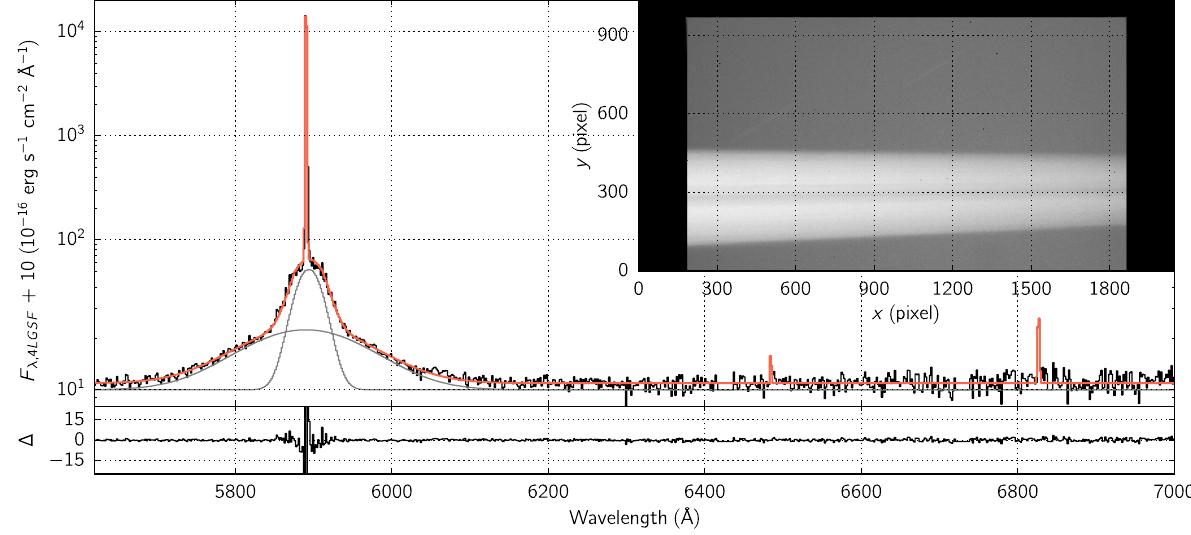
FIG. 7. FORS2 spectra of the uplink beam of LGSU1 from the 4LGSF at an altitude of 25 km above ground (black), and our fit to the spectra (red) including the laser line and the N 2 ð ν 1 ← 0 Þ and O 2 ð ν 1 ← 0 Þ Raman lines. The main laser line at λ 4 components to be properly reproduced. The narrowest component corresponds to the laser photons subject to elastic Rayleigh and Mie scattering. The intermediate Gaussian component corresponds to inelastic rotational Raman scattering and is in fact a superposition of multiple narrow lines associated with different molecules. The broadest component is an instrumental artifact of FORS2. Top right: R-band image from chip 1 of FORS2 acquired at the same location, with the uplink beam (horizontal on the image) clearly visible. The running shadow of the secondary mirror of UT1 makes the innermost region of the laser beam darker. Star trails are visible in the background, given that UT1 was idle during the